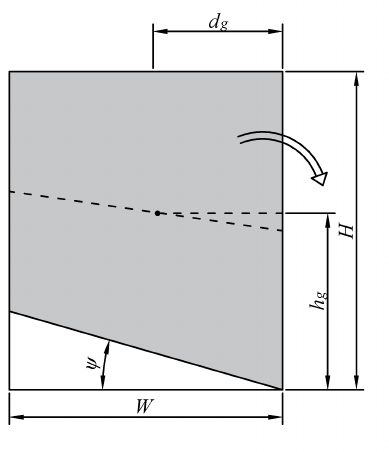
Figure A1. Rotation mode failure mechanism of the